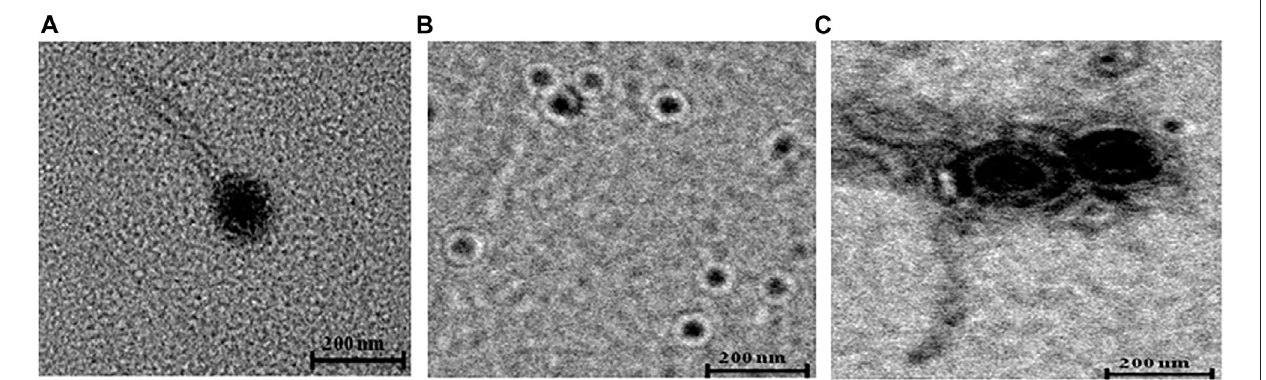
FIGURE 1 | Transmission electron micrographs of phages. ɸ KpBHU4 (A) and ɸ KpBHU14 (C) belong to Siphoviridae family, and ɸ KpBHU7 (B) belongs to Tectiviridae family. The bar indicates 200 nm.